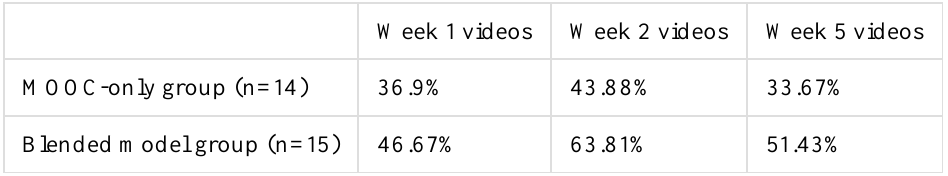
Percentage of Students who Watched Lecture Videos